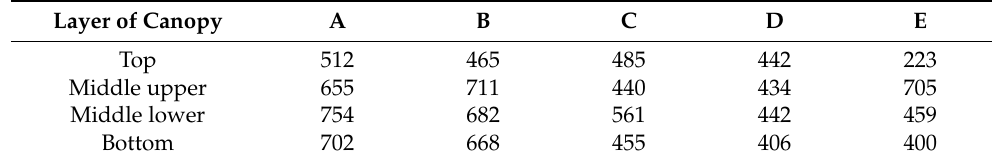
Table 3. The numbers of leaves in different areas of the peach